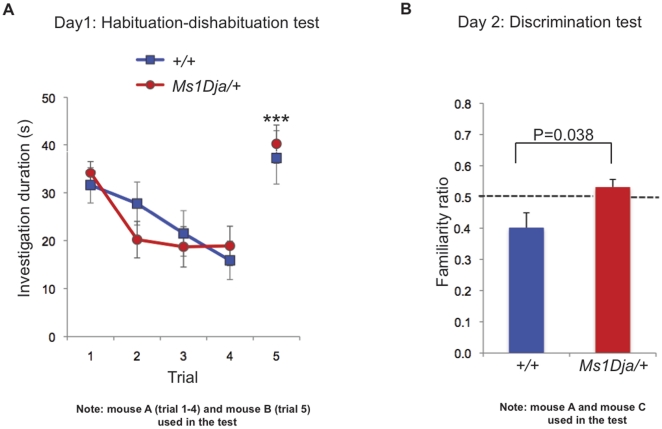
Social recognition test.(A) Habituation-dishabituation test. Both monosomic (Ms1Dja/+, n = 10) and control (+/+, n = 8) mice recognized two different stimulus animals (mouse A and mouse B), as shown by decline in the investigation time over trials 1 to 4 when they were repetitively presented the same (familiar) stimulus animal (mouse A) and increase in the investigation time on trial 5 when they were presented with a novel stimulus animal (mouse B) (trial 4 vs trial 5, *** P<0.0001, post-hoc analysis after two-way anova, the error bars represent the standard error of the mean). (B) Discrimination test. 24 hours after the habituation-dishabituation test. When given a choice between the familiar stimulus mouse (mouse A, thus the mouse used for trials 1 to 4 on day 1) and a new unfamiliar mouse (mouse C), control mice spent significantly less amount of time investigating the familiar stimulus mouse (mouse A) than the unfamiliar one (mouse C). Monosomic (Ms1Dja/+) did not recognize the familiar from the unfamiliar animal, shown by a familiarity ratio close to 0.5 (“chance”, dotted line). Control animals had a significantly smaller familiarity ratio than monosomic (Ms1Dja/+) mice (two-tailed Student's t-test, the error bars represent the standard error of the mean). Five animals (two mutants and three wildtypes) were taken out of the analysis because of their low investigation times (less than 10 seconds on trial 1).